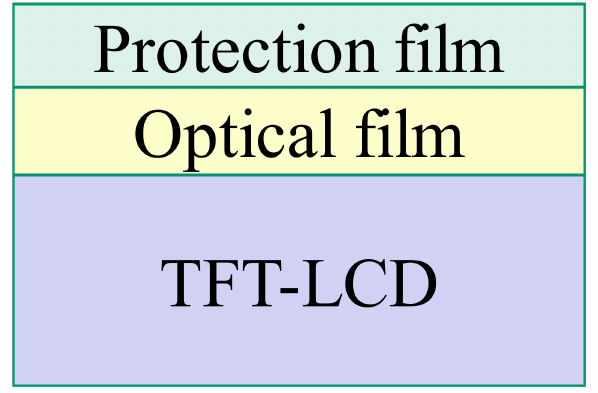
Figure 9. Structure of a TFT-LCD